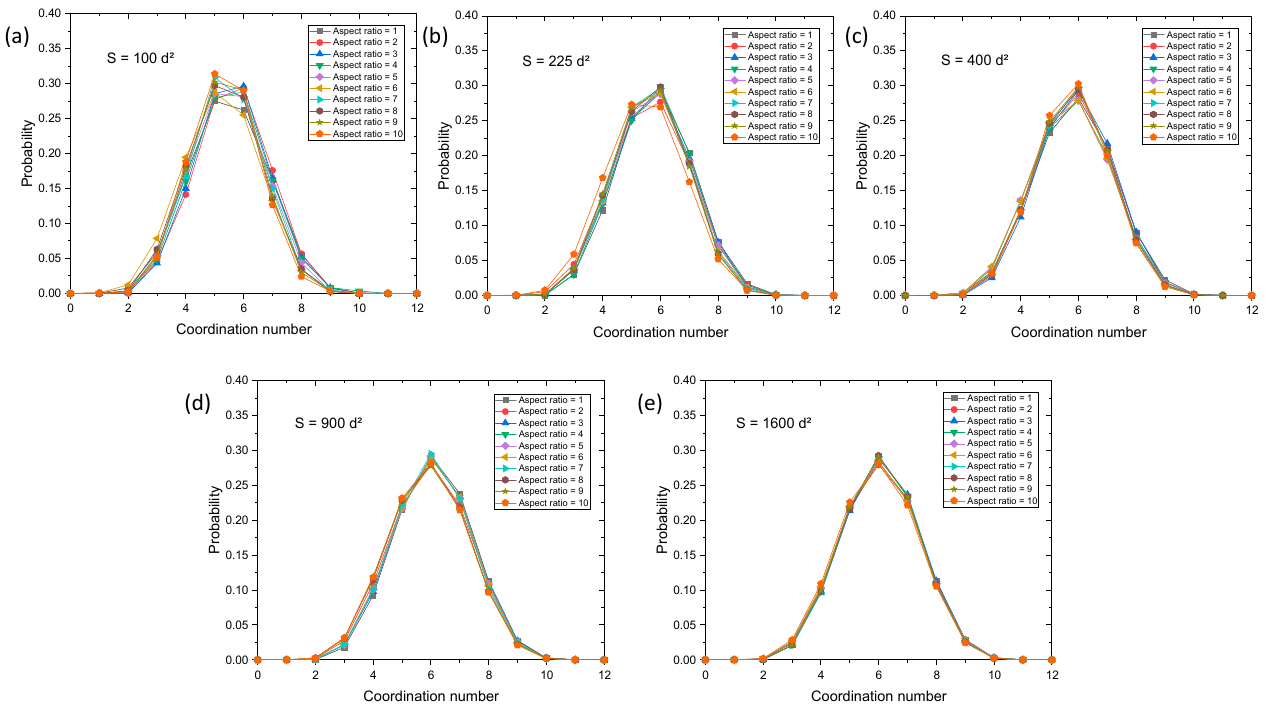
Figure 15. Coordination number distribution of the rectangular packed pebble beds with cross-sectional areas of ( a ) 100 d 2 , ( b ) 225 d 2 , ( c ) 400 d 2 , ( d ) 900 d 2 , ( e ) 1600 d 2 .